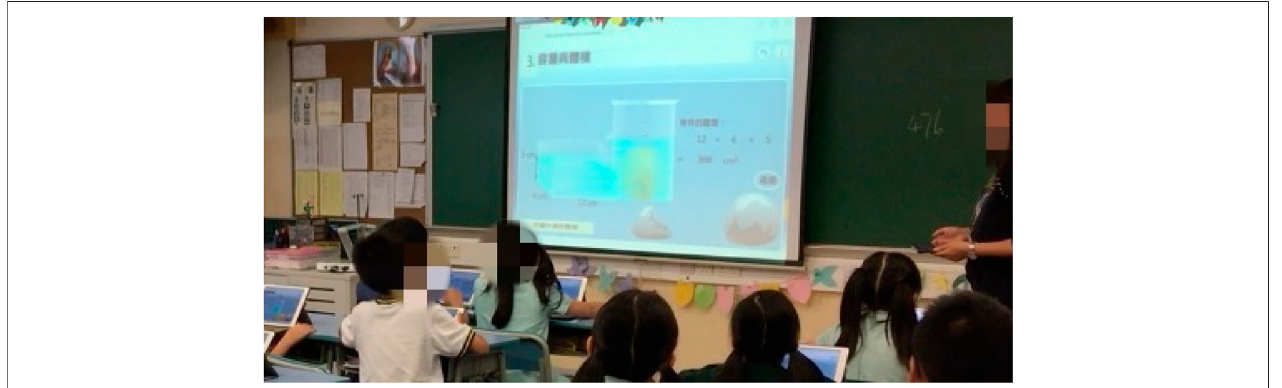
FIGURE 5 | Example of a “ virtual experiment ” to fi nd out the volume of an object using a tablet.